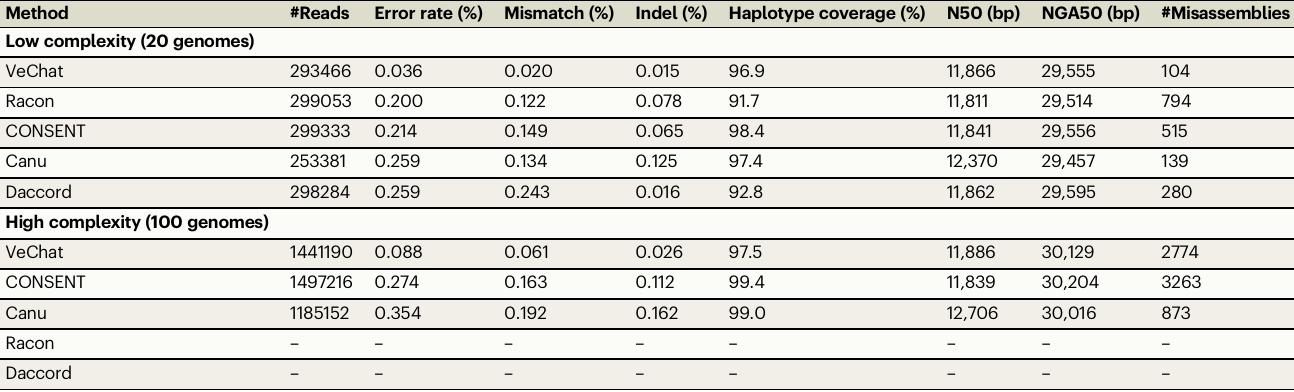
Table 3 | Error correction benchmarking results for simulated PacBio CLR reads of metagenomic datasets with different complexity